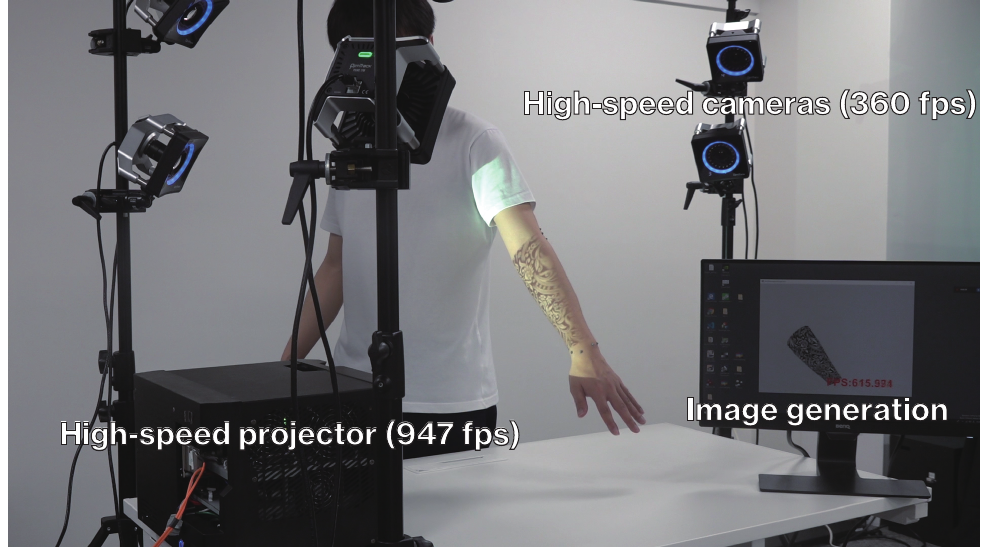
Figure 4. Experimental system